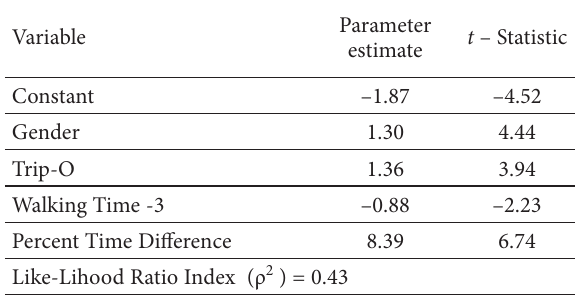
Table 2. The results of model calibration